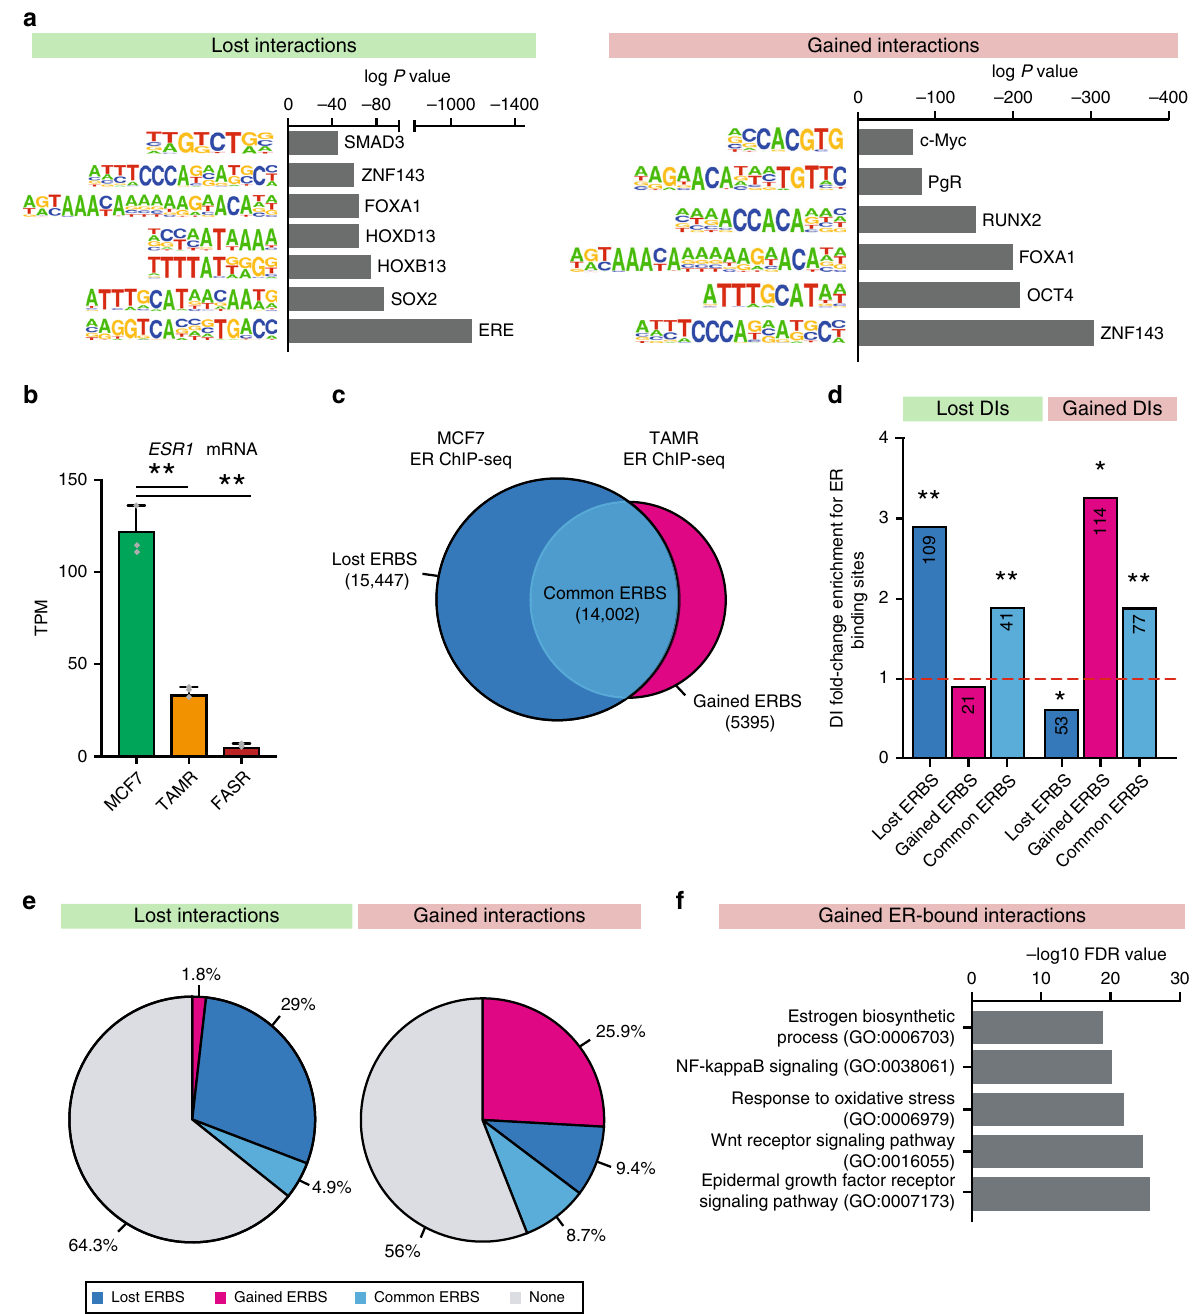
Fig. 3 Differential interactions occur at altered ER binding sites. a Motifs enriched at anchors of lost (left panel) and gained (right panel) interactions between TAMR and MCF7 cells. Known motifs obtained from Homer database and compared to matched, randomised background regions. b ESR1 mRNA expression downregulated in TAMR cells and lost in FASR cells (** P value < 0.001, SD, n = 3) . c Venn diagram showing lost and gained ER binding sites (ERBS) in TAMR cells as compared to parental MCF7 cells identi fi ed with diffBind. ChIP-seq data obtained from Ross-Innes et al. 37 . d Differential interactions (DIs) enrichment for ER binding sites lost and gained between TAMR and MCF7 cells. Asterisks represent the signi fi cance of fold-change enrichment at observed vs. random regions (permutation test). ** P value < 0.001, * P value < 0.005. The numbers of ER binding sites located within each speci fi c region are presented in the respective column. e Proportion of the lost and gained differential interactions between TAMR and MCF7 cells that overlap ER binding sites. f Gene Ontology terms enriched at ER-bound differential interactions gained in TAMR cells as compared to MCF7